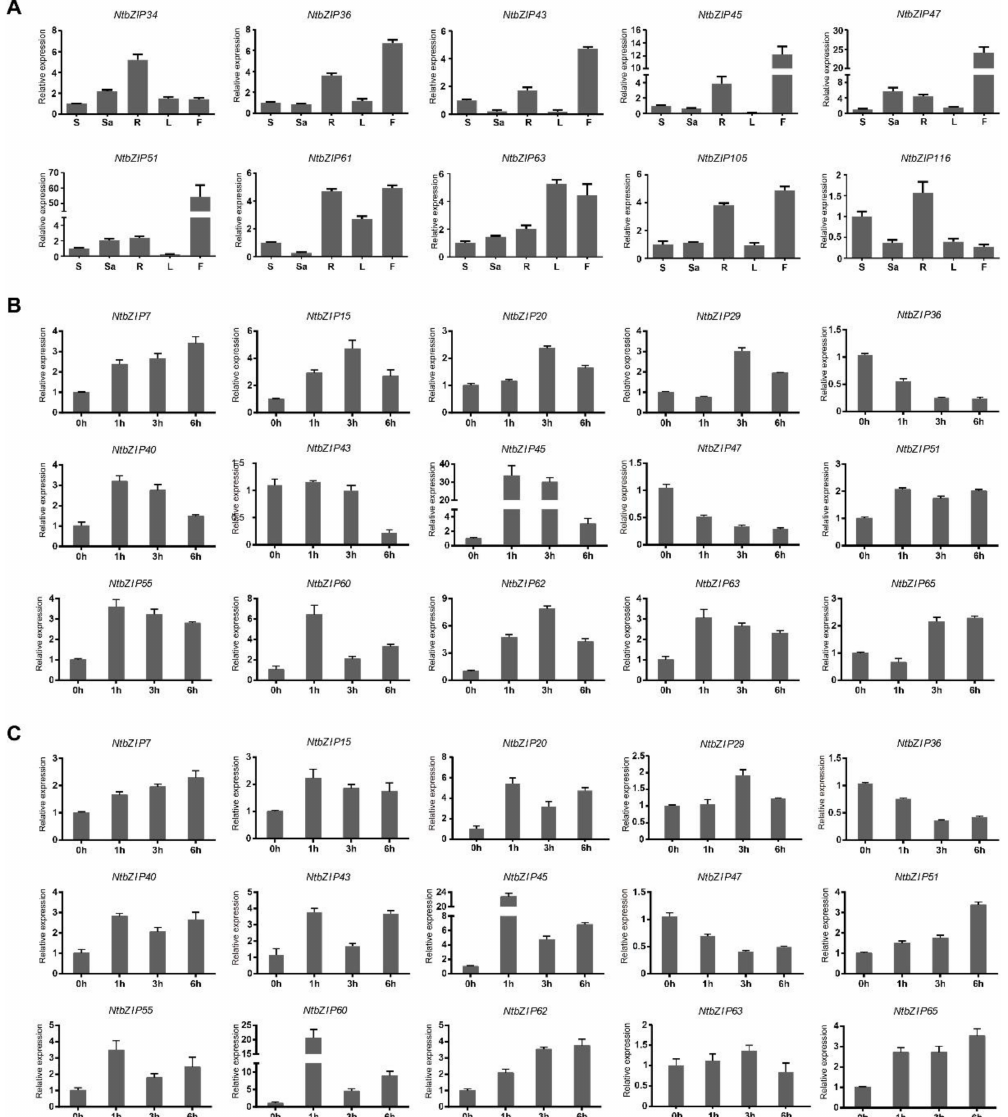
Figure 7. qRT-PCR analysis of representative NtbZIP genes from different groups. ( A ) To verify the tissue specificity expression of the representative NtbZIP genes, the expression level of each NtbZIP gene was calculated relative to the shoot. ( B ) The expression level of representative NtbZIP genes under salt stress treatments. ( C ) expression level of representative NtbZIP genes under Abscisic Acid (ABA) stress